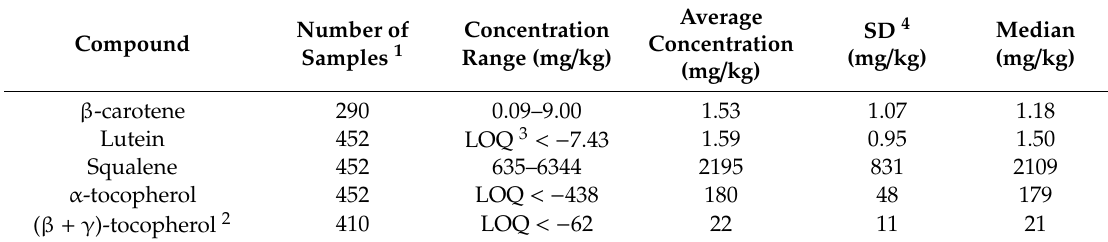
Table 6. Pigment, tocopherols, and squalene